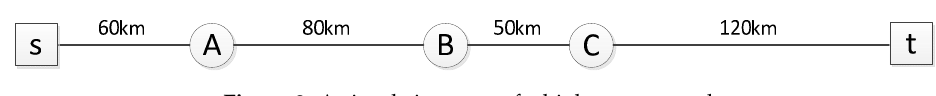
Figure 2. A simple instance of a highway network.